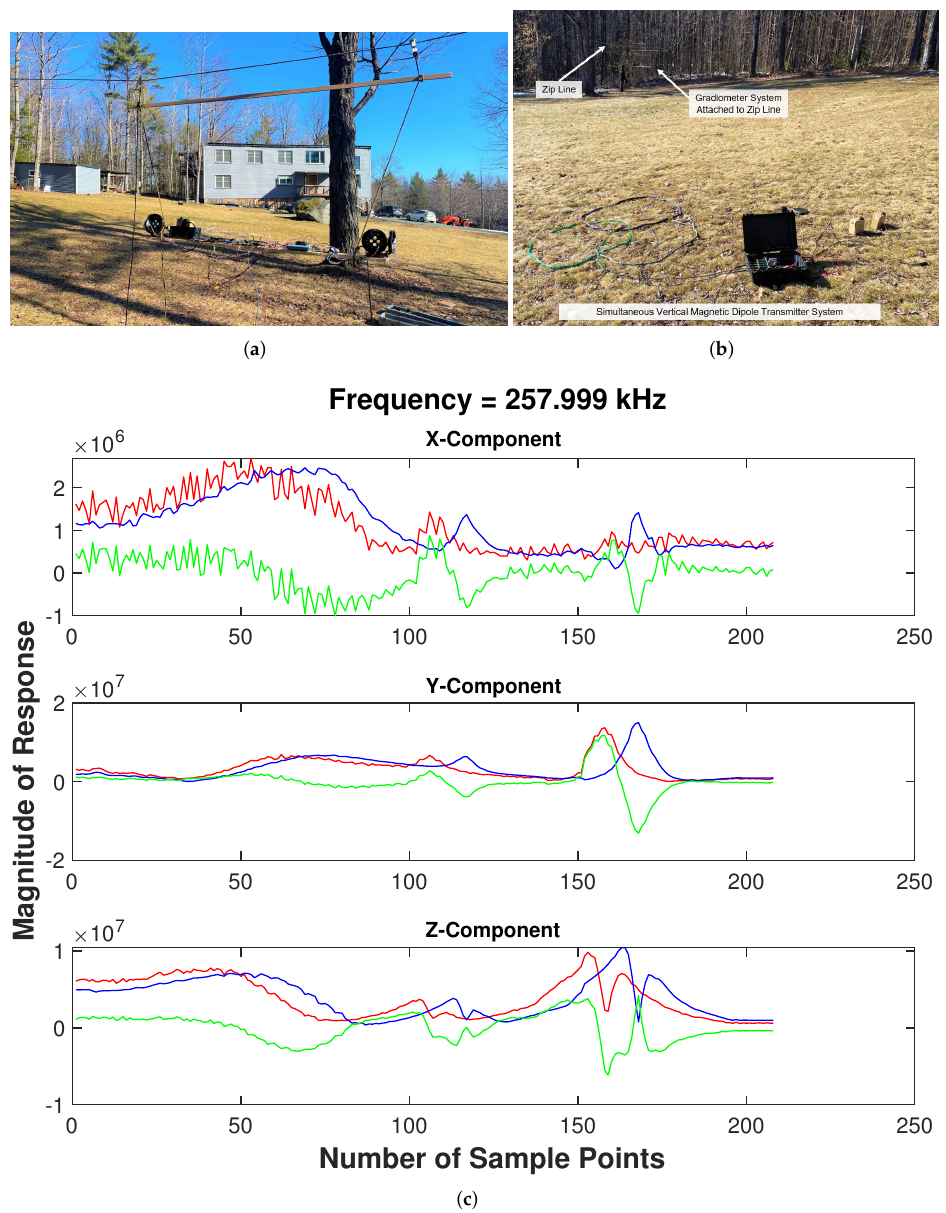
Figure 18. Zip line testing. ( a ) Gradiometer sensor attached to a constructed zip line. ( b ) Transmitter system with gradiometer sensor attached to the zip line in the background. ( c ) Results from vertical magnetic dipole TX Survey—red and blue lines plot the response from the front and back gradiometer receivers, respectively. The green line plots the magnitude of the front RX subtracted by the magnitude of the back